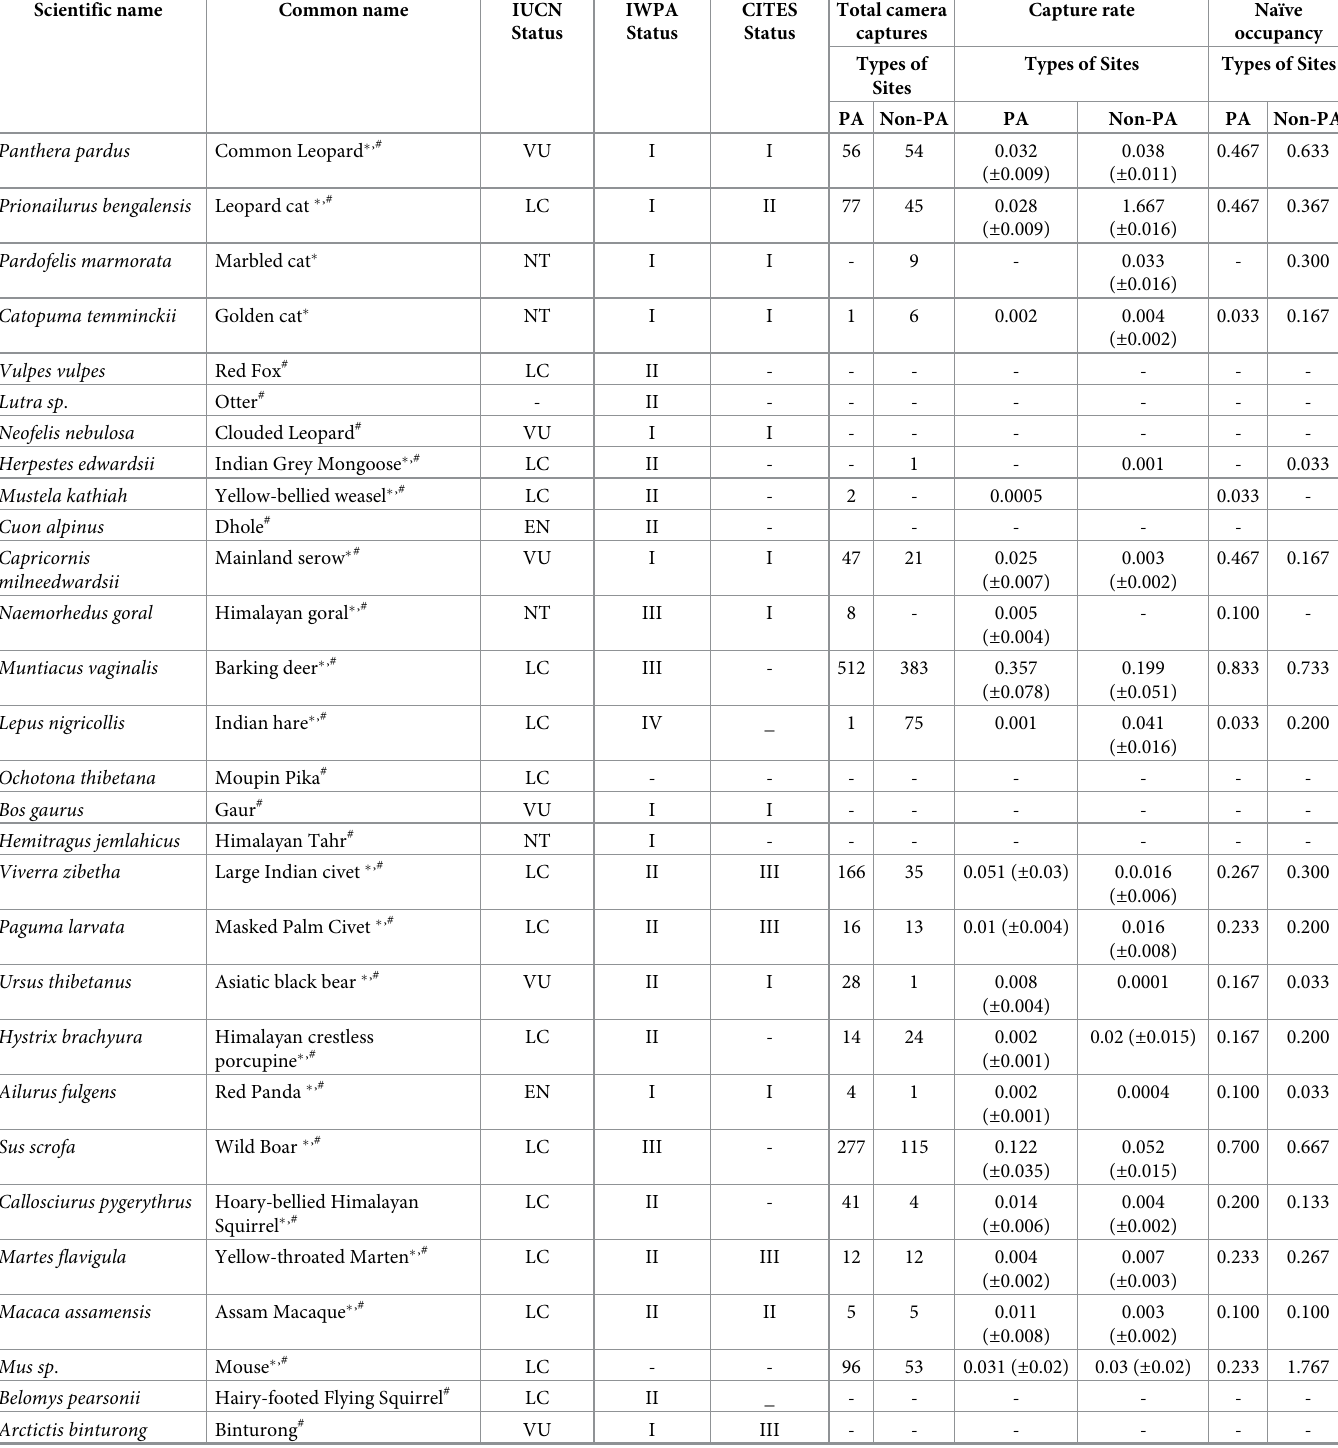
Table 1. A list of mammal species recorded during the study, their functional guild, scientific name, common name, IUCN status, IWPA status, CITES status, cap- ture rate, total number of captures of each species and na ï ve occupancy in PA and non-PA ranges of Darjeeling district, North